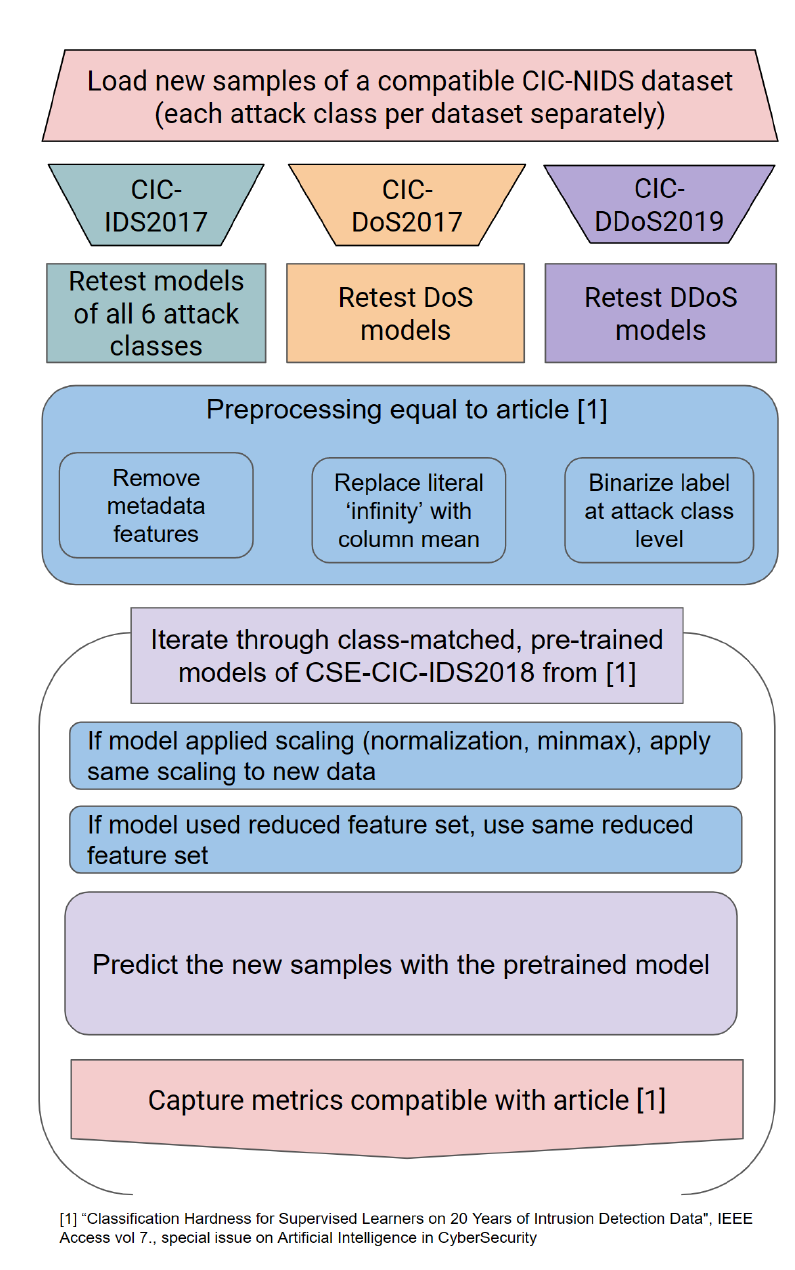
Figure 1. Visual overview of the experimental